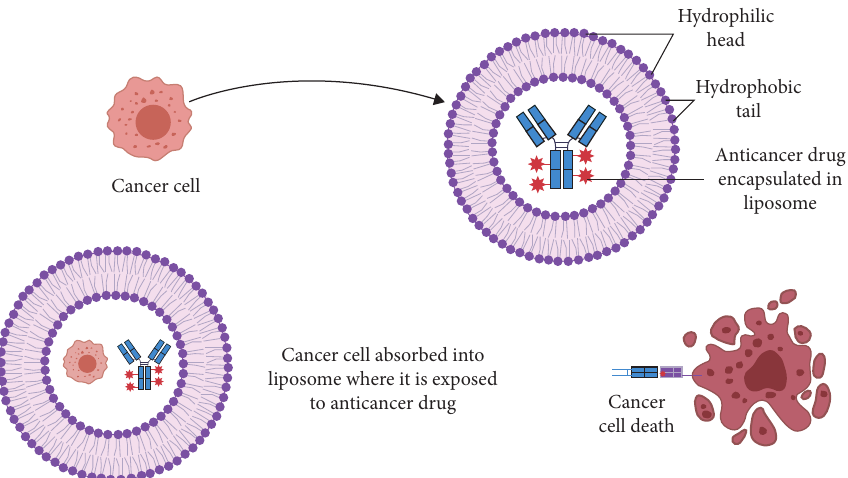
Figure 12: Illustration of working of a liposome encapsulating anticancer drug against cancer cell. Table 8: Effects of encapsulation of the drug by niosomes on its activity. Sr no. Drug encapsulated by Niosomes